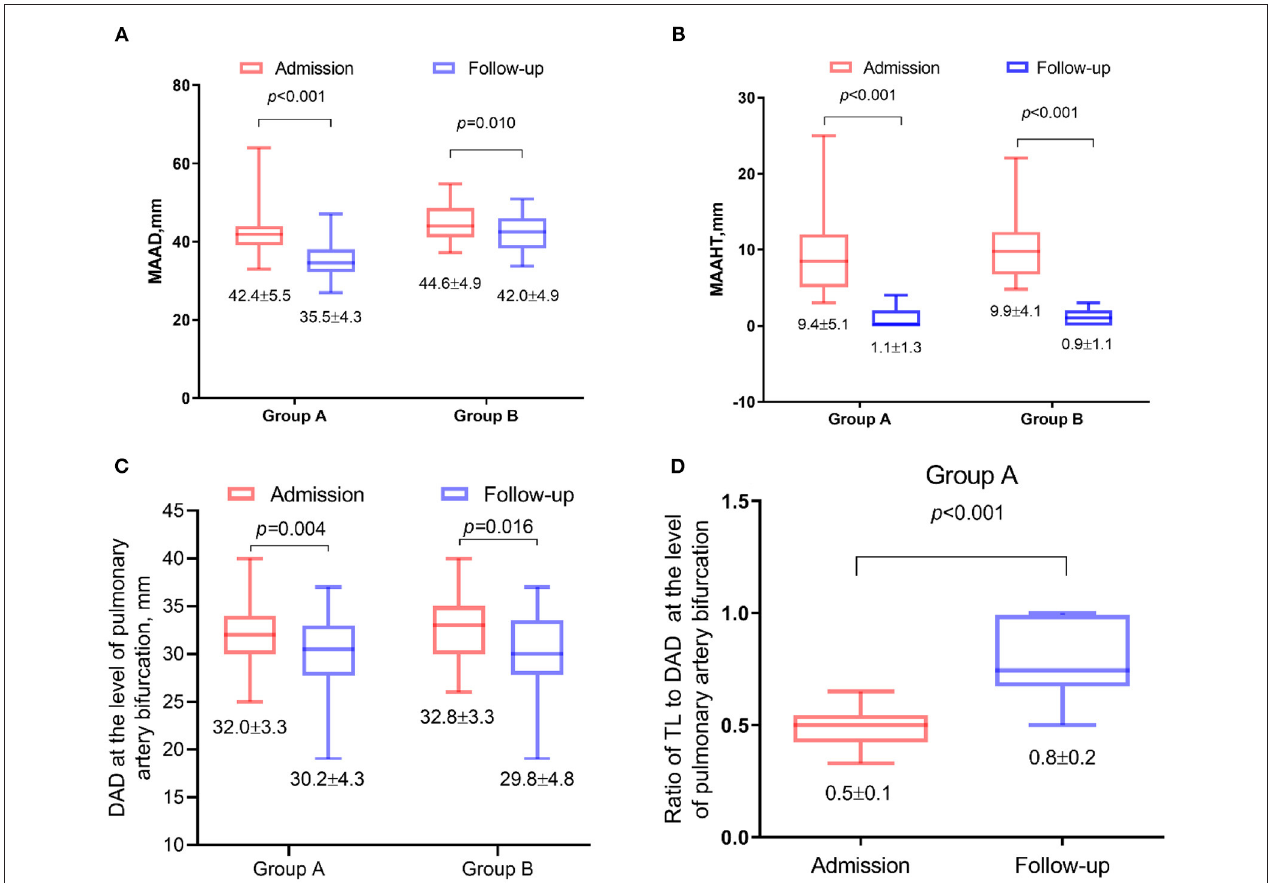
FIGURE 4 | Changes in contrast-enhanced computed tomography angiography (CTA) parameters 1 year after thoracic endovascular aortic repair (TEVAR). Data were plotted as box-and-whiskers plots. The upper and lower borders of the box represented the upper and lower quartiles. The middle horizontal line represented the median. The upper and lower whiskers represent the maximum and minimum values. The values of mean and standard deviation were also showed below. (A) Comparison of the maximal ascending aortic diameter (MAAD). (B) Maximal ascending aortic hematoma thickness (MAAHT). (C) The mean descending aortic diameter at the pulmonary bifurcation level. (D) The ratio of true lumen (TL) to descending aortic diameter at the pulmonary bifurcation